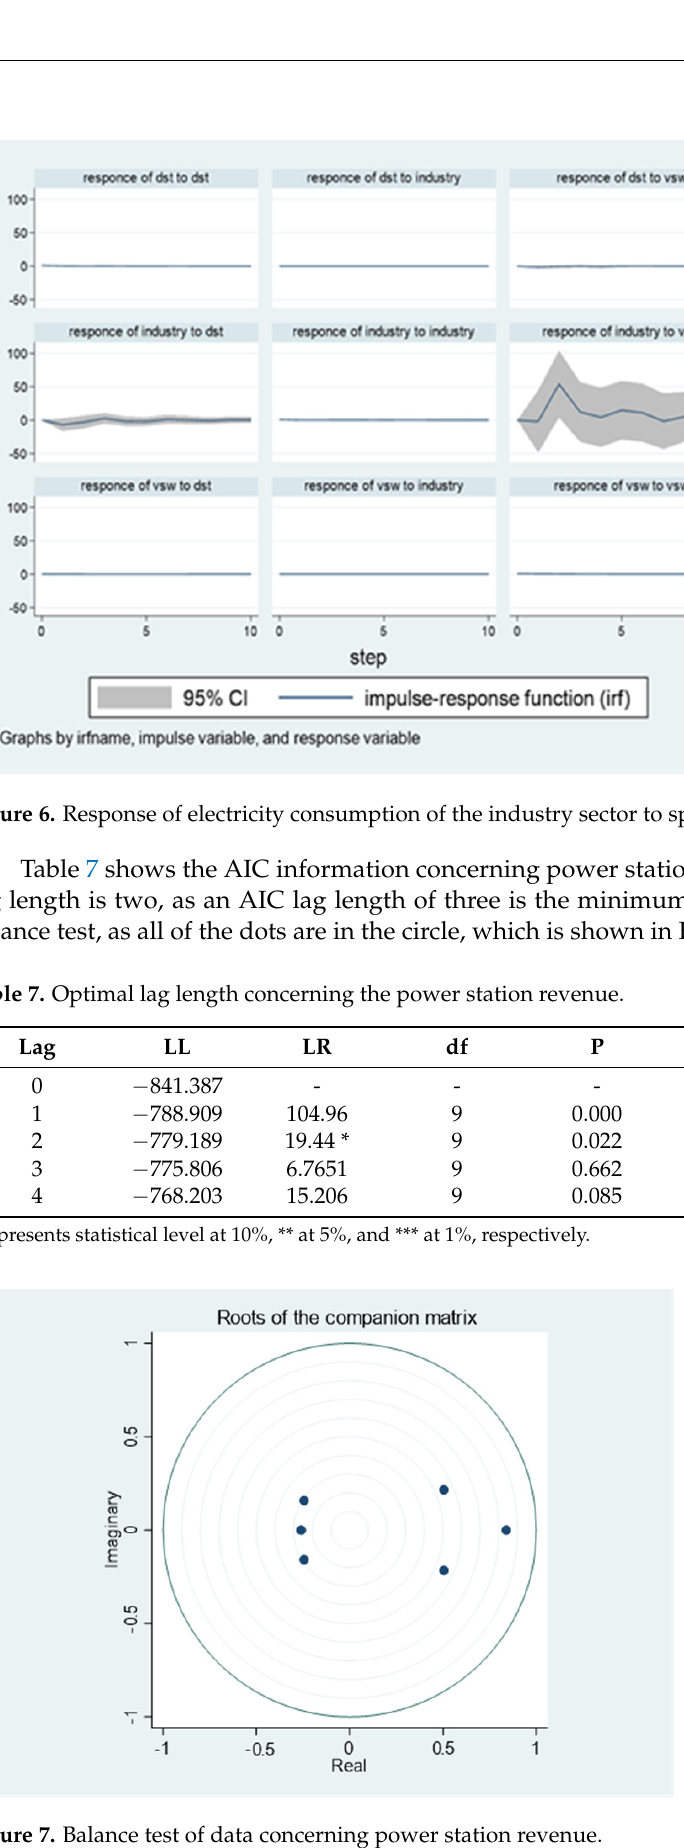
Figure 7. Balance test of data concerning power station revenue .